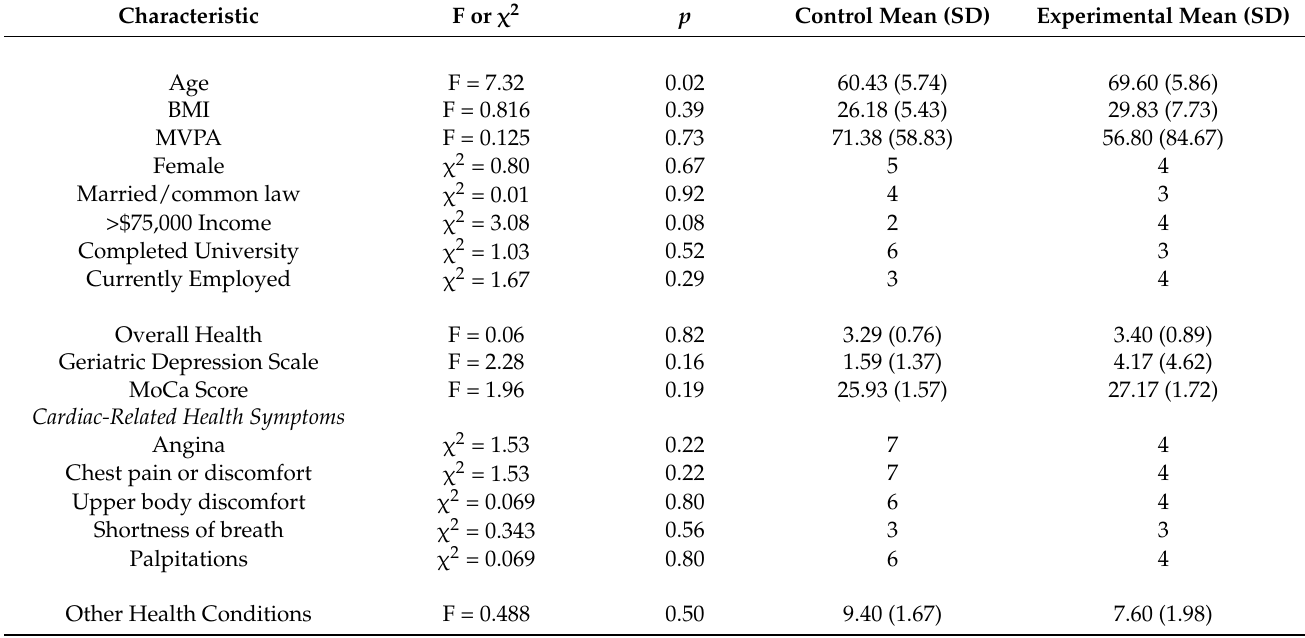
Table 1. Demographic characteristics of the